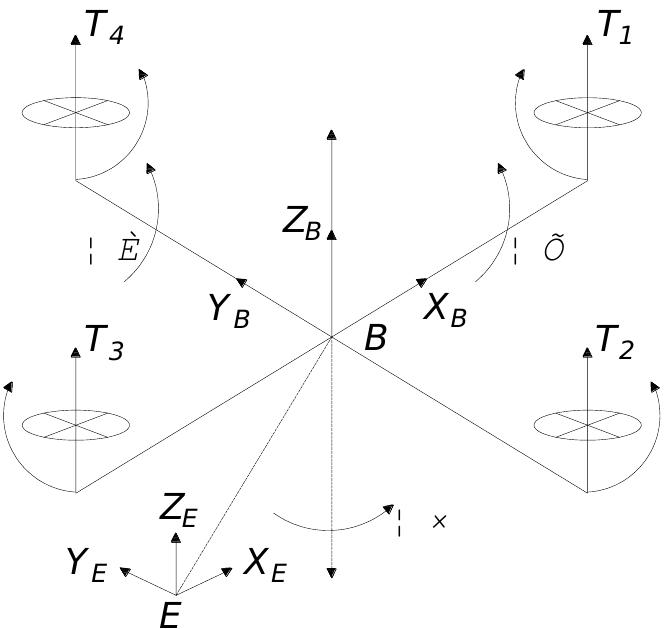
Figure 1. Diagram of the movement of the quadrotor UAV.